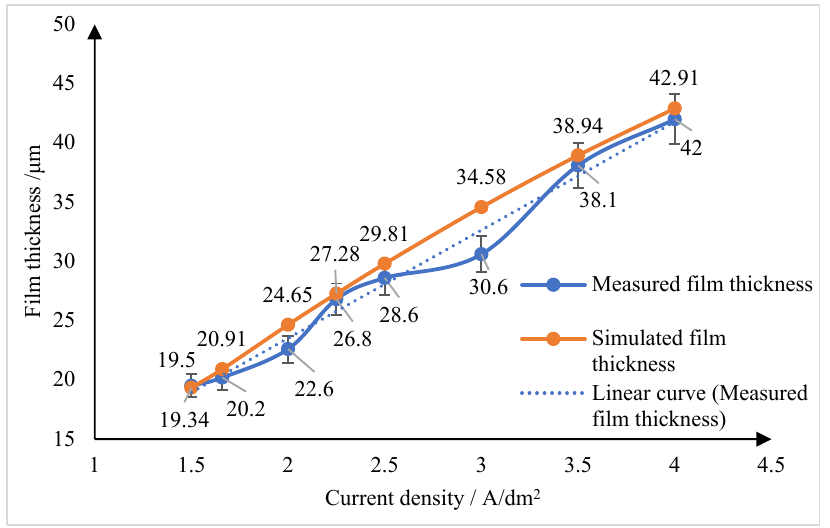
Figure 4. Measured film thickness and simulated film thickness with different current densities (the lines are only guidelines).